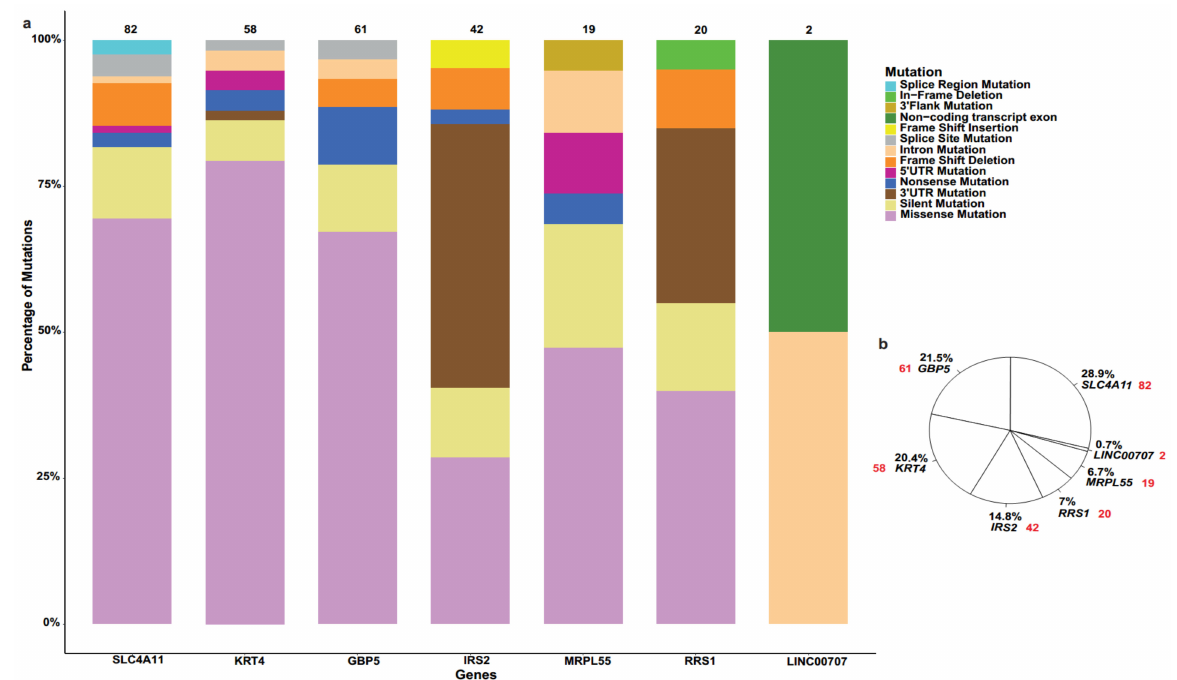
Figure 3. ( a ) Bar plot indicating different types of mutations associated with seven biomarkers in female cancers. ( b ) Pie chart specifying the percentage distribution of 284 SNPs for 7 biomarkers in female cancers, where red colour represents the number of mutations in each gene.